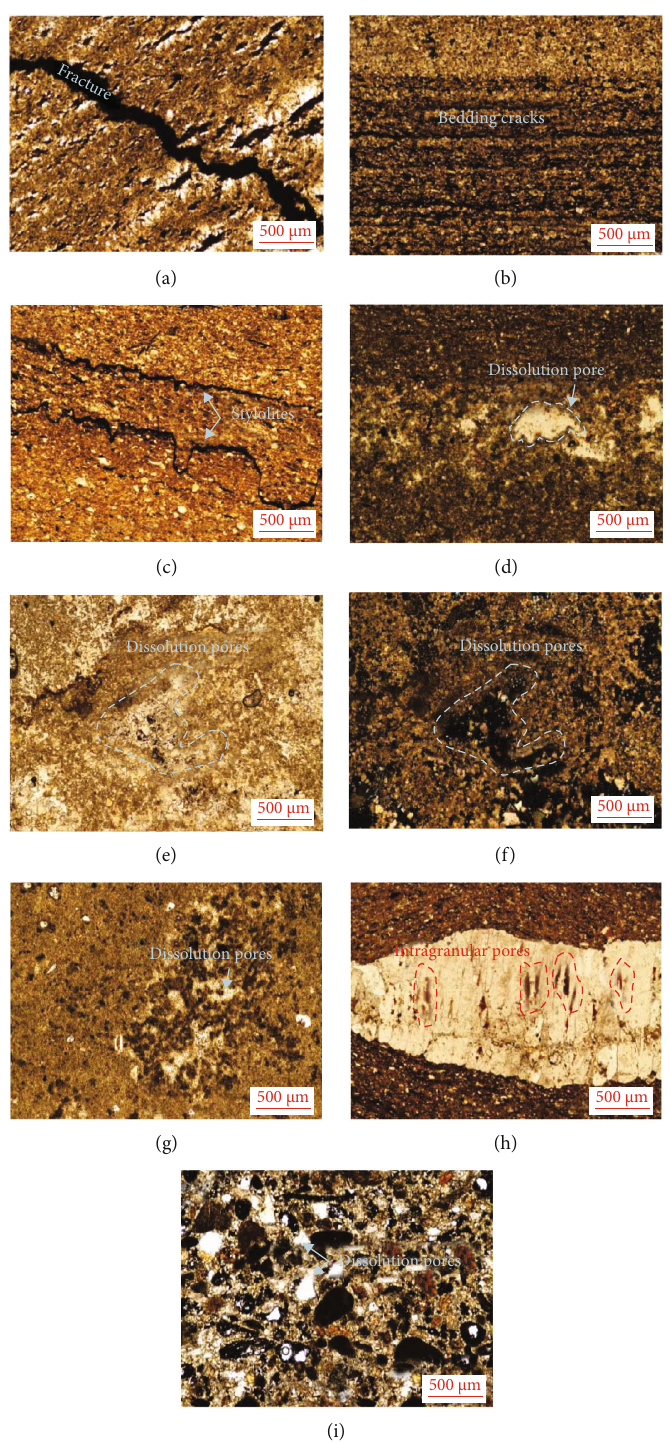
Figure 6: Photomicrographs showing the reservoir space types in the Lucaogou Formation, Jimusar Sag: (a) well J10025, 3516.15m, dolomitic mudstone with fractures; (b) well J303, 2600.31 m, dolomitic silty mudstone with bedding cracks fi lled with organic matter; (c) well J305, 3582.73 m, stylolites fi lled with organic matter (plane-polarized light); (d) well J43, 2947.45 m, calcareous siltstone with dissolution pores (plane-polarized light); (e) well J301, 2768.3m, argillaceous dolomite showing iron dolomitization and dissolution and intercrystalline pores (plane-polarized light); (f) the same fi eld of view as (e) but in cross-polarized light; (g) well J301, 2771.8m, dolomicrite with abundant dissolution pores (plane-polarized light); (h) well J43, 2953 m, abundant intragranular pores in the veins of carbonate minerals, which are fi lled with organic matter (plane-polarized light); (i) well J10025, 3552.58m, dolarenite with abundant dissolution and intergranular pores (plane-polarized